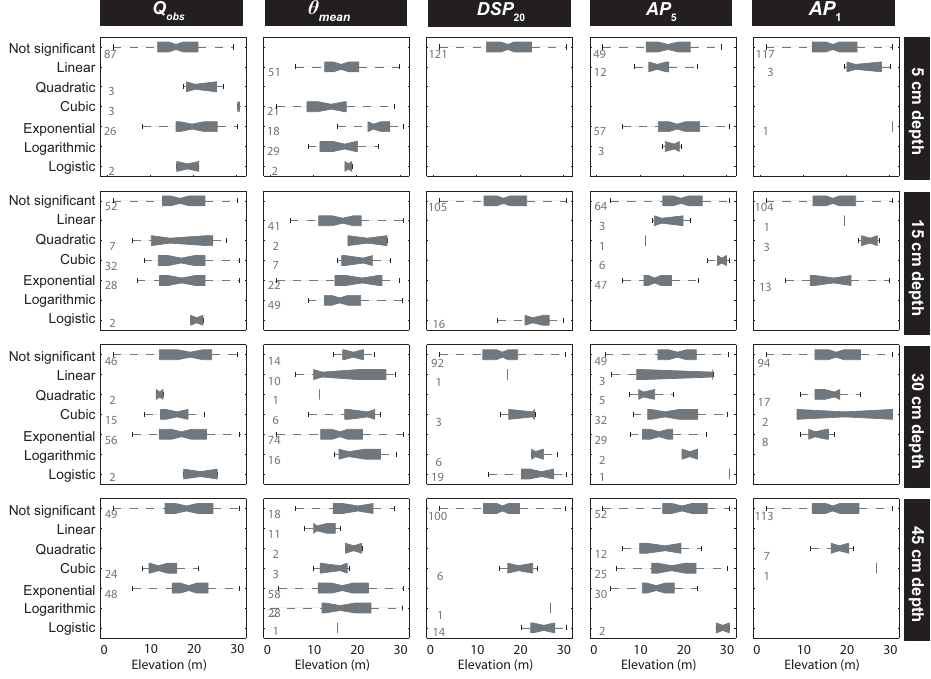
Fig. 8. Influence of surface topography (elevation above the catchment outlet) on the nature of the relationship between point-scale soil moisture (columns) and selected proxies for AMCs, catchment macrostate and catchment response (rows) in the Hermine. Grey numbers illustrate the number of data used to plot each